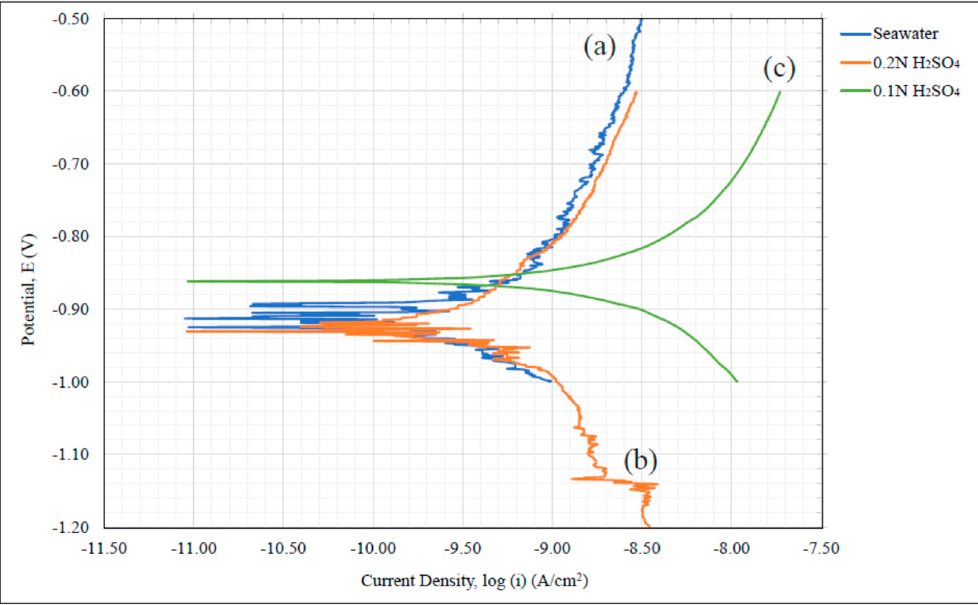
Figure 2. Polarization curves for porous C / Al in seawater from [ − 1.0, − 0.6] V as curve ( a ), 0.2 N H 2 SO 4 from [ − 1.2, − 0.6] V as curve ( b ), and 0.1 N H 2 SO 4 from [ − 0.94, − 0.78] V as curve ( c ). For each curve, a horizontal line may be drawn, which denotes to the location of pseudo E corr . In addition, positive and negative sloped lines can also be constructed to determine β a and β c rates, respectively. Finally, a vertical line can be drawn, which provides the pseudo i corr . Refer to Table 1 for data reduction.